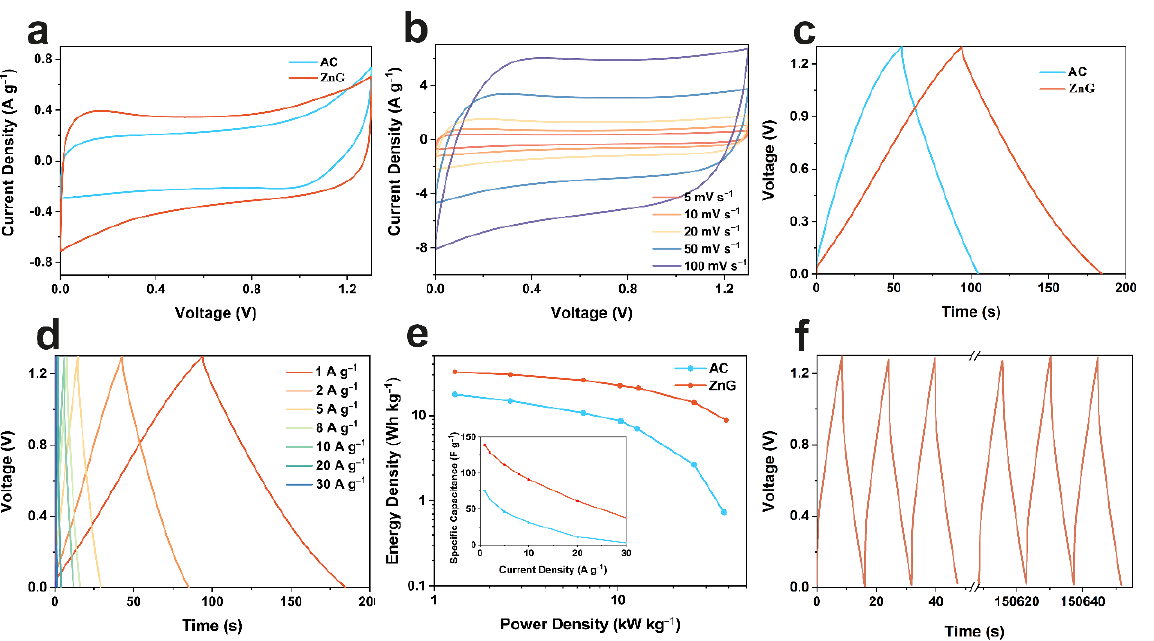
Figure 4. Electrochemical performance of ZnG and AC in symmetric supercapacitor. CV curves at 5 mV · s − 1 ( a ); CV curves of ZnG symmetric supercapacitor at different scan rates ( b ); GCD profiles at 1 A · g − 1 ( c ); GCD profiles of ZnG symmetric supercapacitor at different current densities ( d ); Ragone plots and specific capacitance at different current densities ( e ); and the first and the final three cycles of cycling tests ( f ).